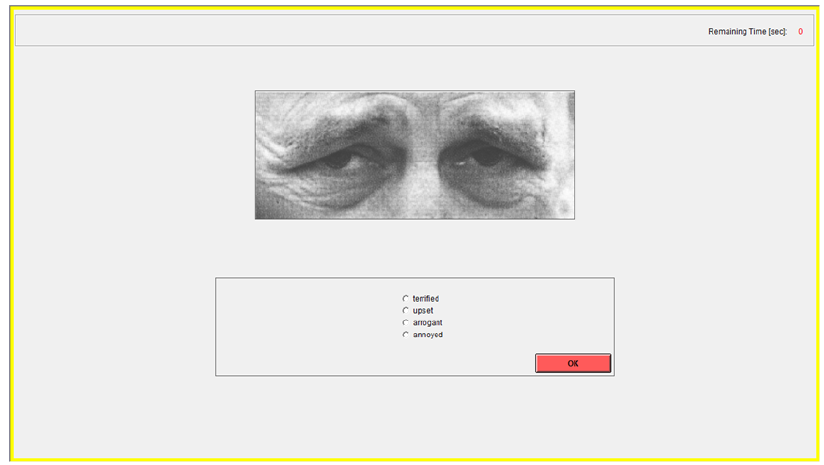
Figure 2. Example of reading the mind in the eyes test (RMET)